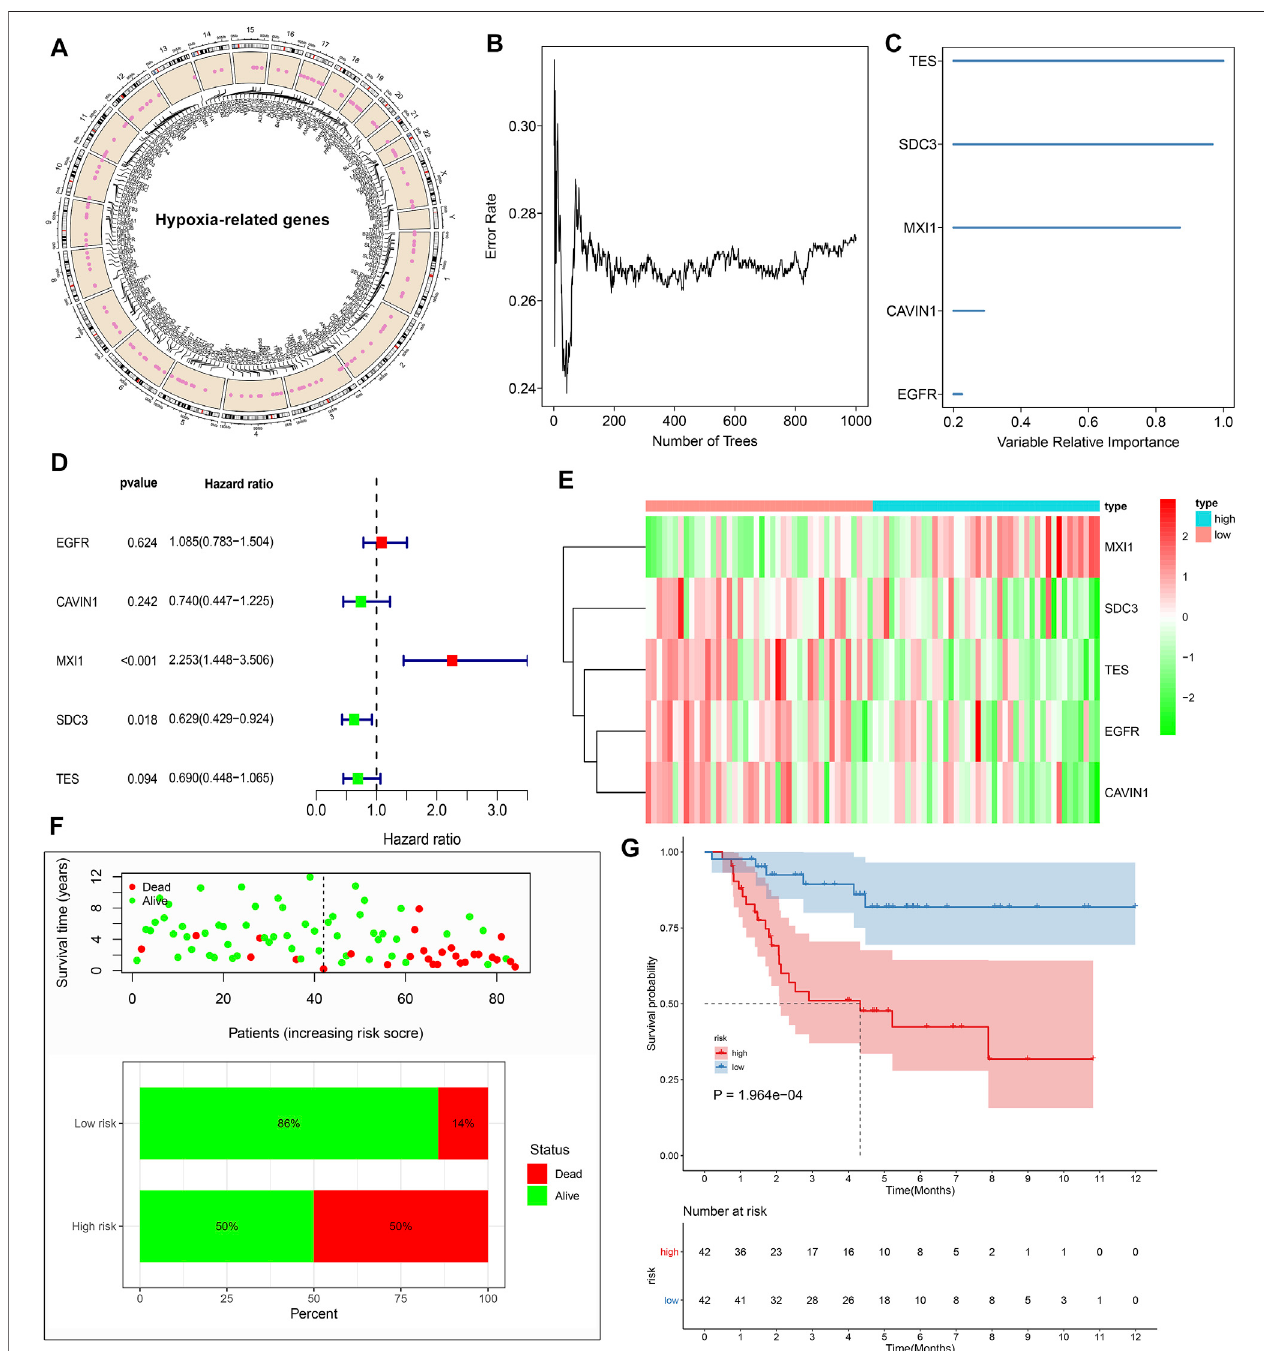
FIGURE 2 | Establishment of a prognostic hypoxic gene signature in osteosarcoma in the TARGET cohort. (A) The chromosomal locations of 197 hypoxic genes. (B) The relationships between the number of trees and error rates. (C) The rank of relative importance of the top fi ve variables. (D) Univariate cox regression analysis of TES, SDC3, MXI1, CAVIN1, and EGFR in osteosarcoma. (E) Heat map visualizing the up- (red) and down-regulated (green) genes in high- and low-risk groups. (F) The distributions and proportions of survival status (alive: green; dead: red). (G) Kaplan-Meier curves of OS between high- and low-risk specimens. The differences were compared by log-rank